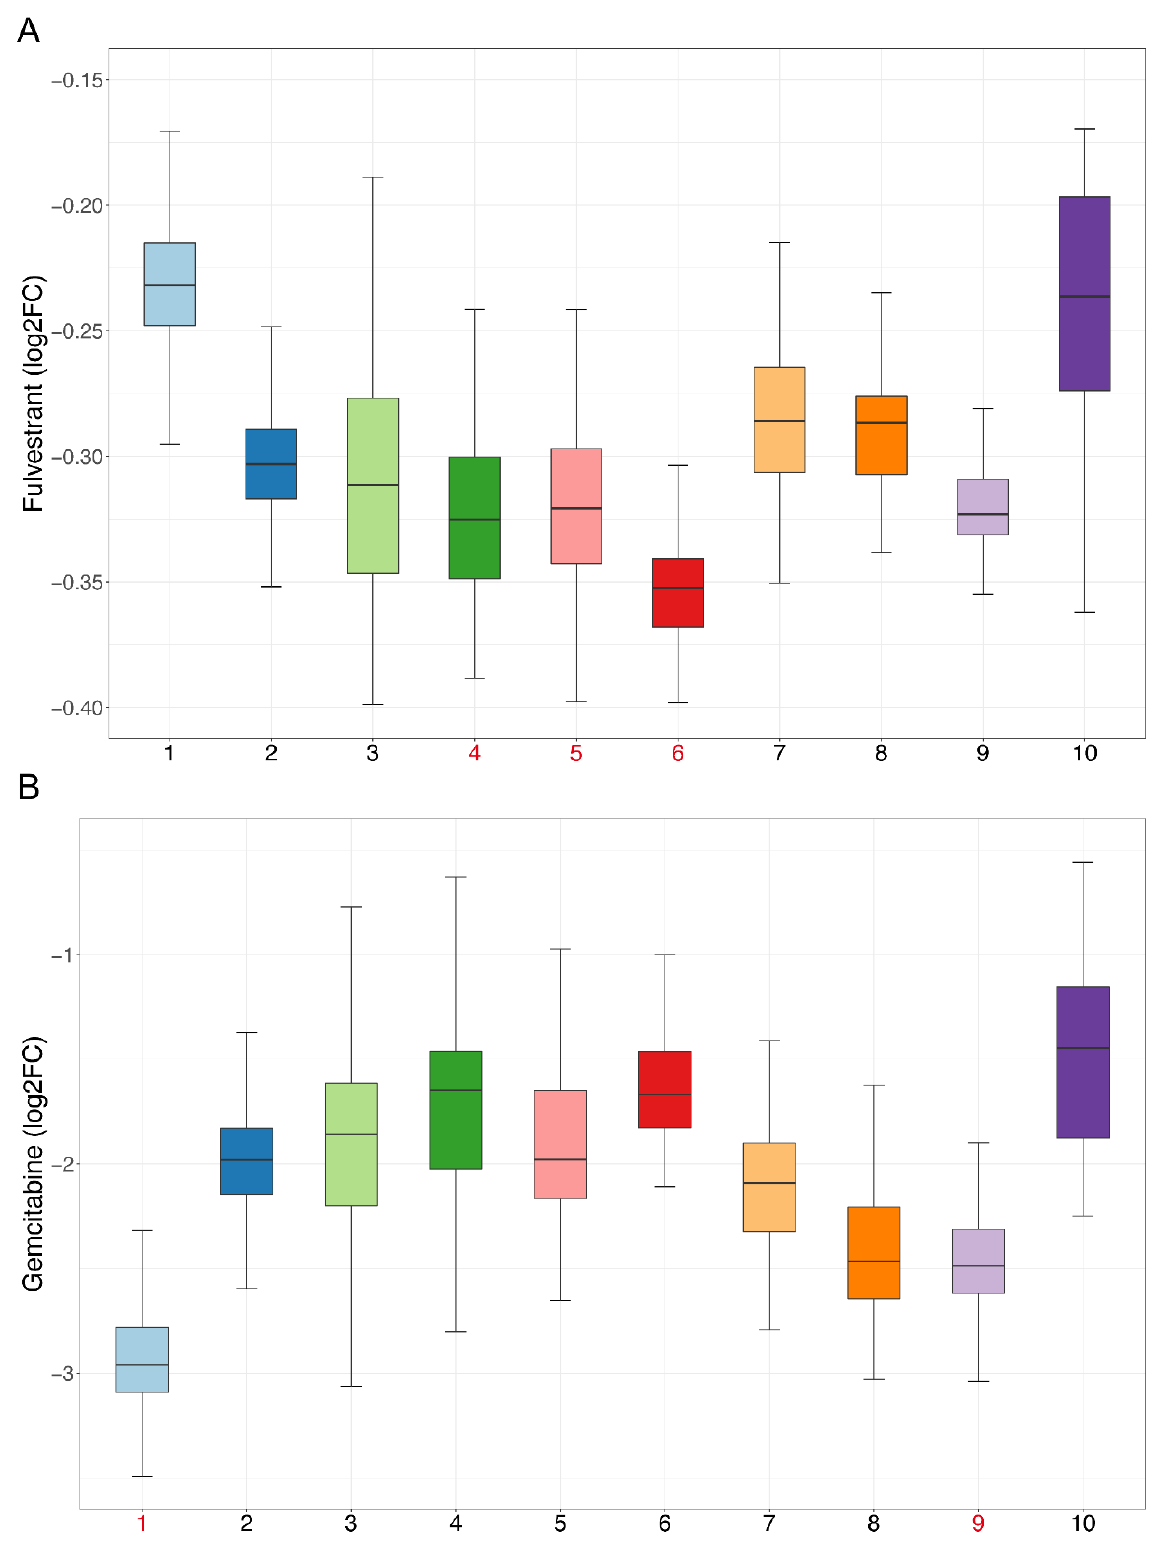
Figure 7. Sensitivity of candidate drugs: The x -axis represents cell clusters, and the y -axis represents the logFC (drug sensitivity data from the CCLE are represented using relative log fold-change values of cell lines’ viability to DMSO). Cell clusters with the highest drug sensitivity mentioned in our study are marked in red. ( A ) Sensitivity of fulvestrant. ( B ) Sensitivity of gemcitabine.